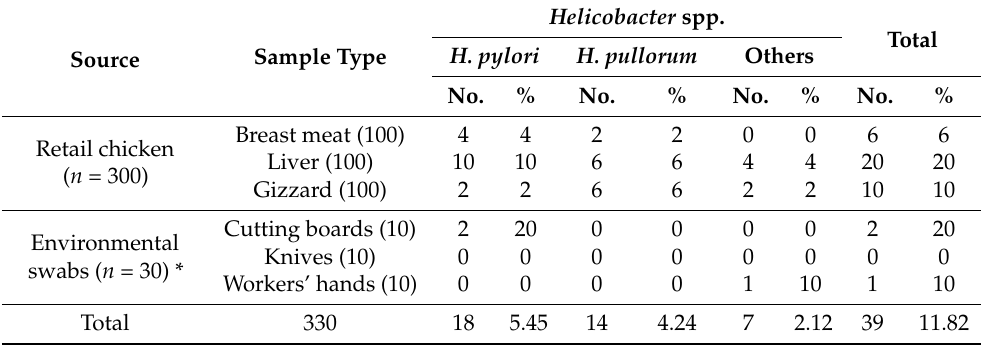
Table 2. Prevalence of Helicobacter species in chicken meat and their associated environment at the retail